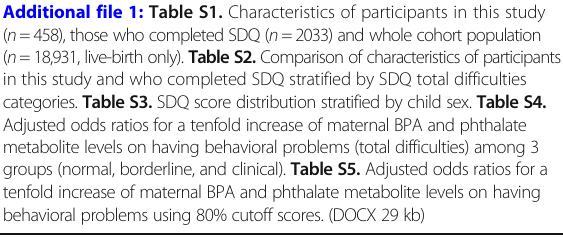
Abbreviations BASC-2: Behavioral Assessment System for Children-Second